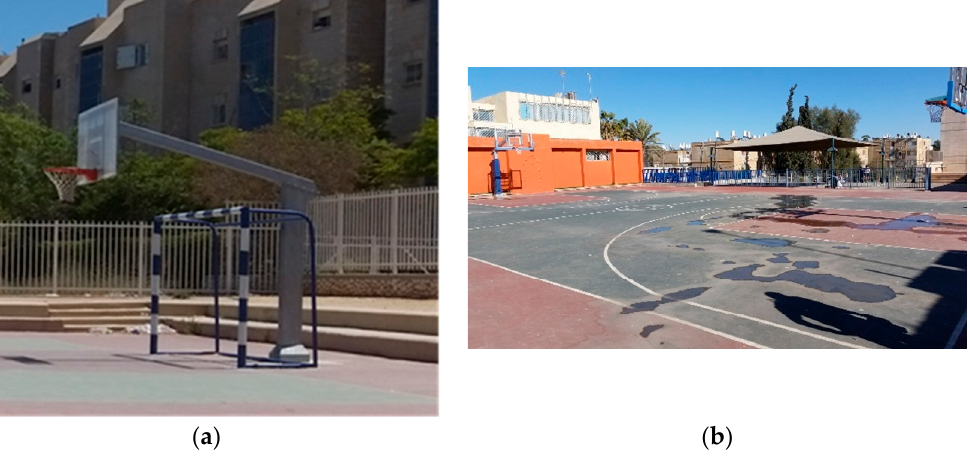
Figure 5. Sports—( a ) unprotected basket column and ( b ) poorly maintained basketball surface.